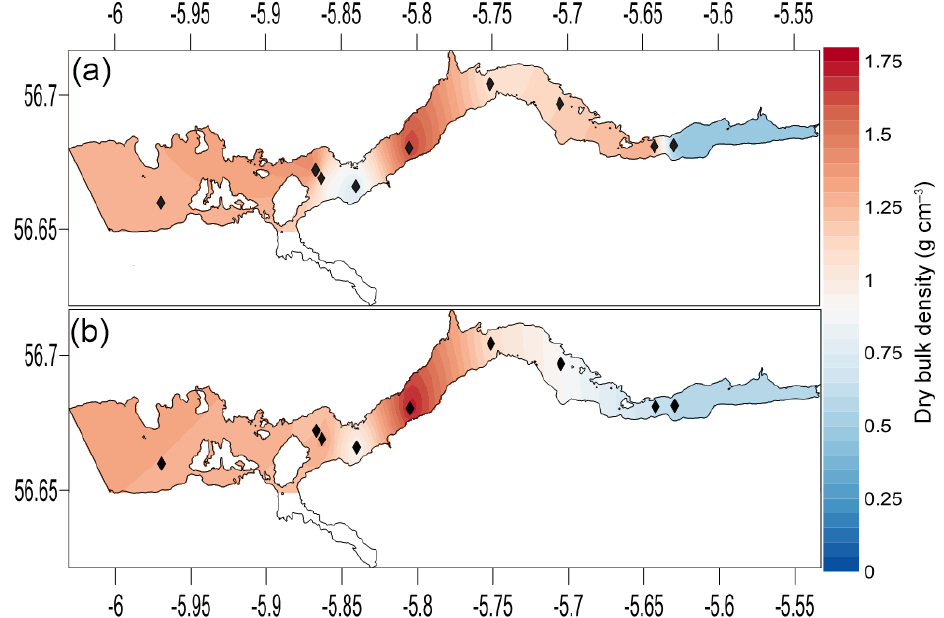
Figure 6. Contour maps showing the output of the spatial distribution model for the mean dry bulk density of (a) U3 and (b) U2. Sampling locations indicated with black diamonds. Table 4. Mass of sediment held within Loch Sunart and the mass of total carbon (TC), organic carbon (OC) and inorganic carbon (IC) held within Loch Sunart’s postglacial (PG) and glacial (G)